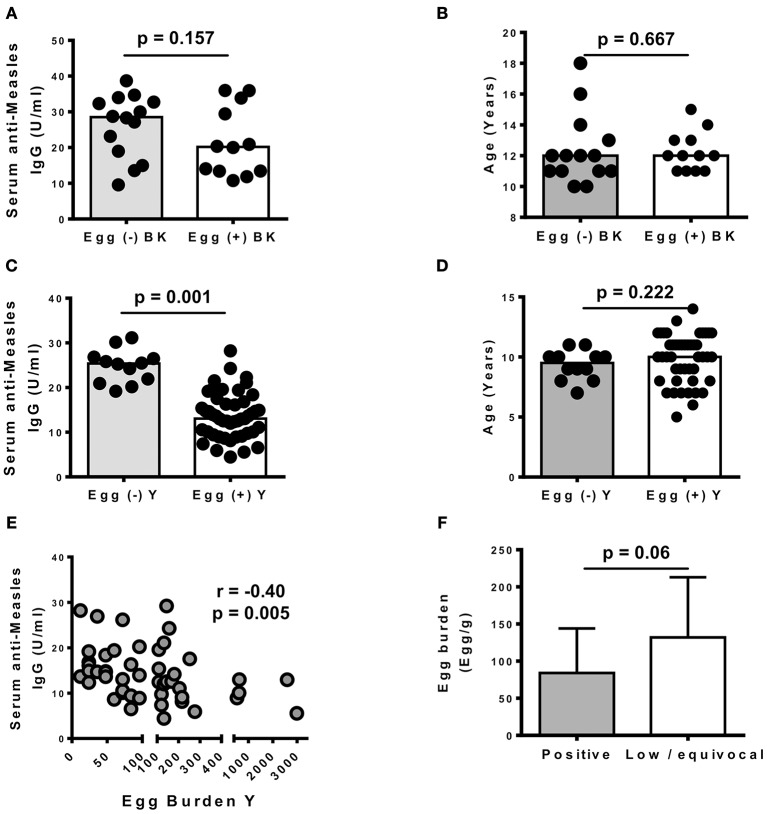
Effect of Schistosomiasis infections on vaccine-induced anti-measles responses in schoolchildren from Barombi Kotto and around Yoro river. (A) Influence of S. haematobium (BK) infection on serum anti-measles IgG levels. N = 26 with 14 egg (–) and 12 egg (+) (B) Age distribution in children tested for vaccine responses in BK. (C) Influence of S. mansoni (Y) infection on serum anti-measles IgG levels. N = 59 with 12 egg (–) and 47 egg (+). (D). Age distribution in children tested for vaccine responses in Y. (E) Correlation between S. mansoni egg burdens and serum anti-measles IgG levels in Yoro. (F) Egg burdens and anti-measles antibody titers in examined children from Yoro. Low / equivocal (< 12 U/ml); positive titers (≥12 U/ml). Bars represent the medians and vertical lines represent the interquartile ranges.